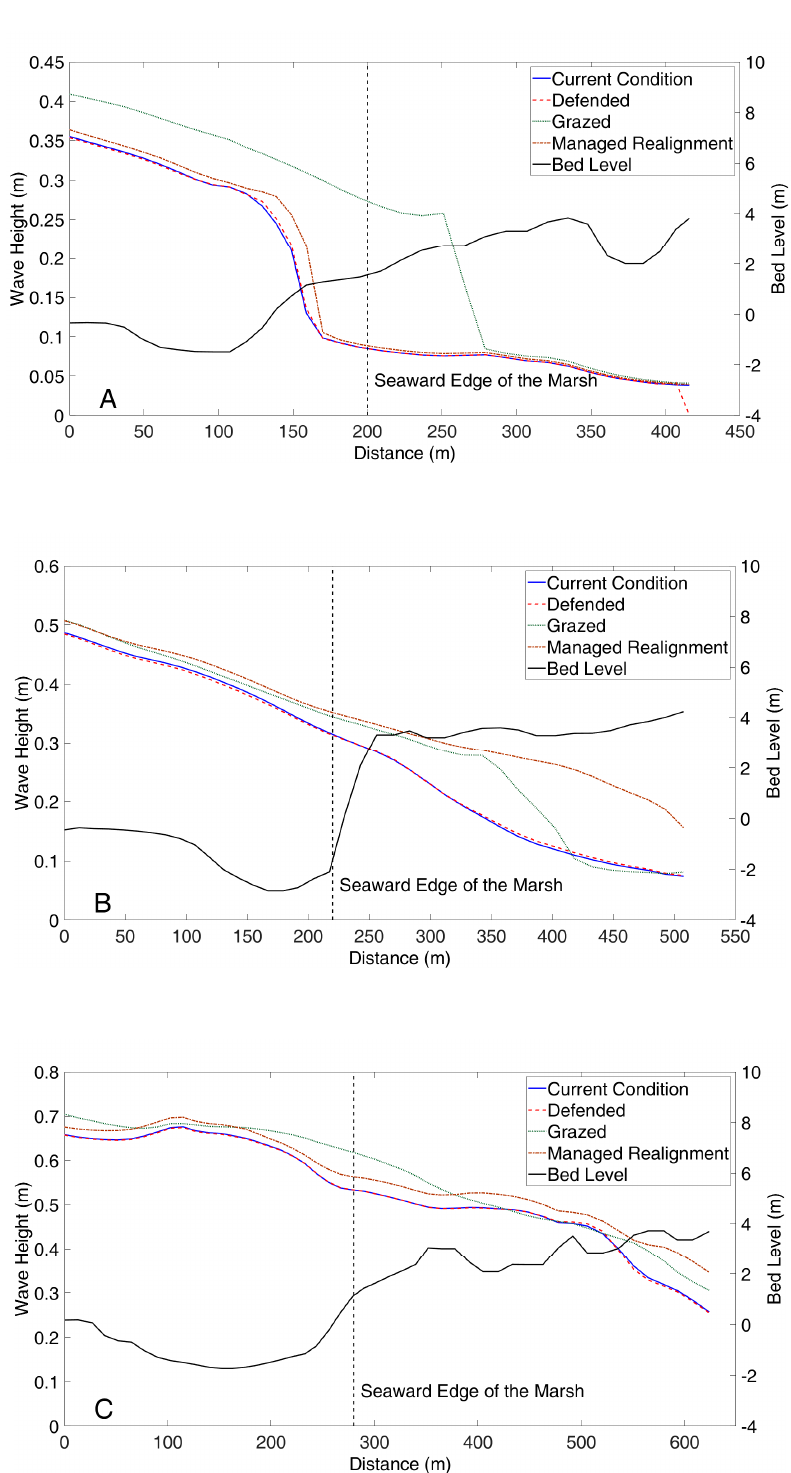
Figure 15. Comparison of peak storm wave height for the 1:50 year south-westerly storm condition at T1 ( A ), T2 ( B ), and T3 ( C ). Initial bed level, given in black line, is in m OD. Right hand side is the landward